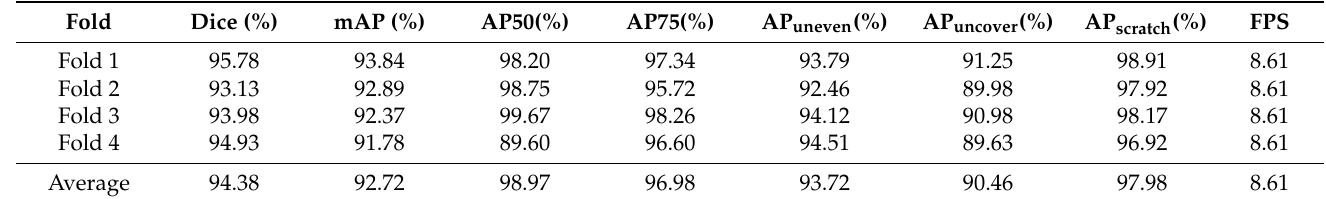
Table 8. Four-fold cross validation result, where FPS denotes for frame per second by using Mask- RCNN with ResNet 152 backbone. In total, the number of parameters used is 101,188,563.